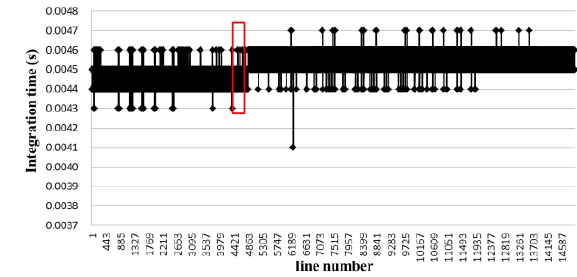
Figure 4. The change of integration time of CE-2